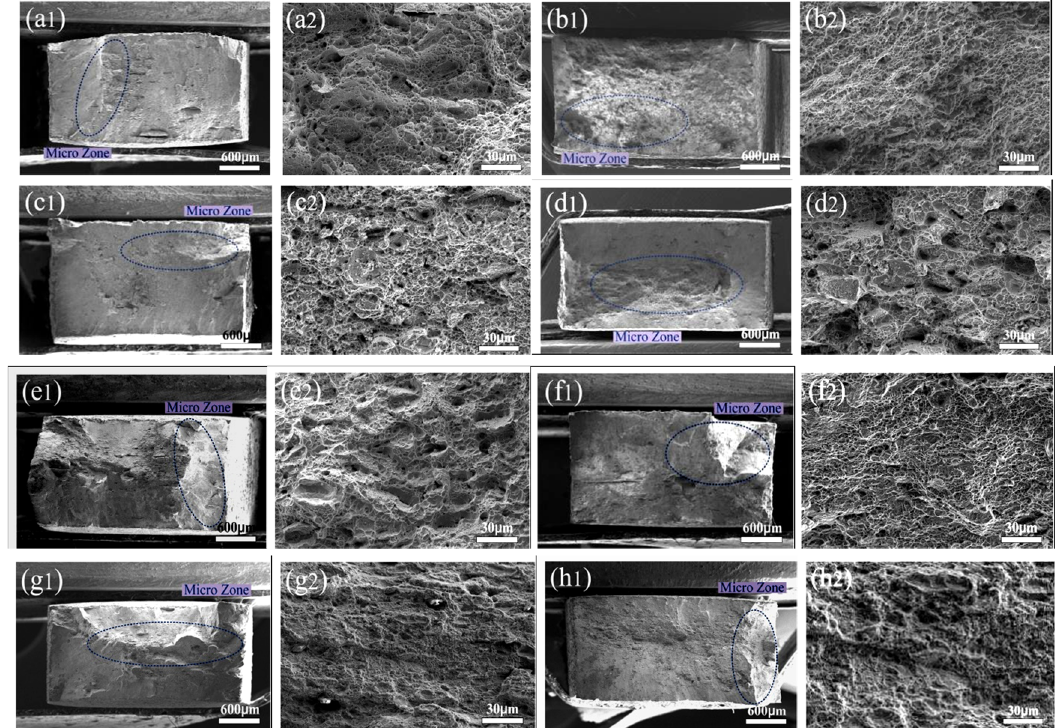
Figure 7: Fracture surface morphology of samples in air and di ff erent Cl − concentration media: a1 – h1: macroscopic; a2 – h2: microscopic; ( a ) air; ( b ) 3.5% NaCl; ( c ) 7% NaCl; ( d ) 10.5% NaCl; ( e ) 14% NaCl; ( f ) 17.5% NaCl; ( g ) 21% NaCl; and ( h ) 24.5%